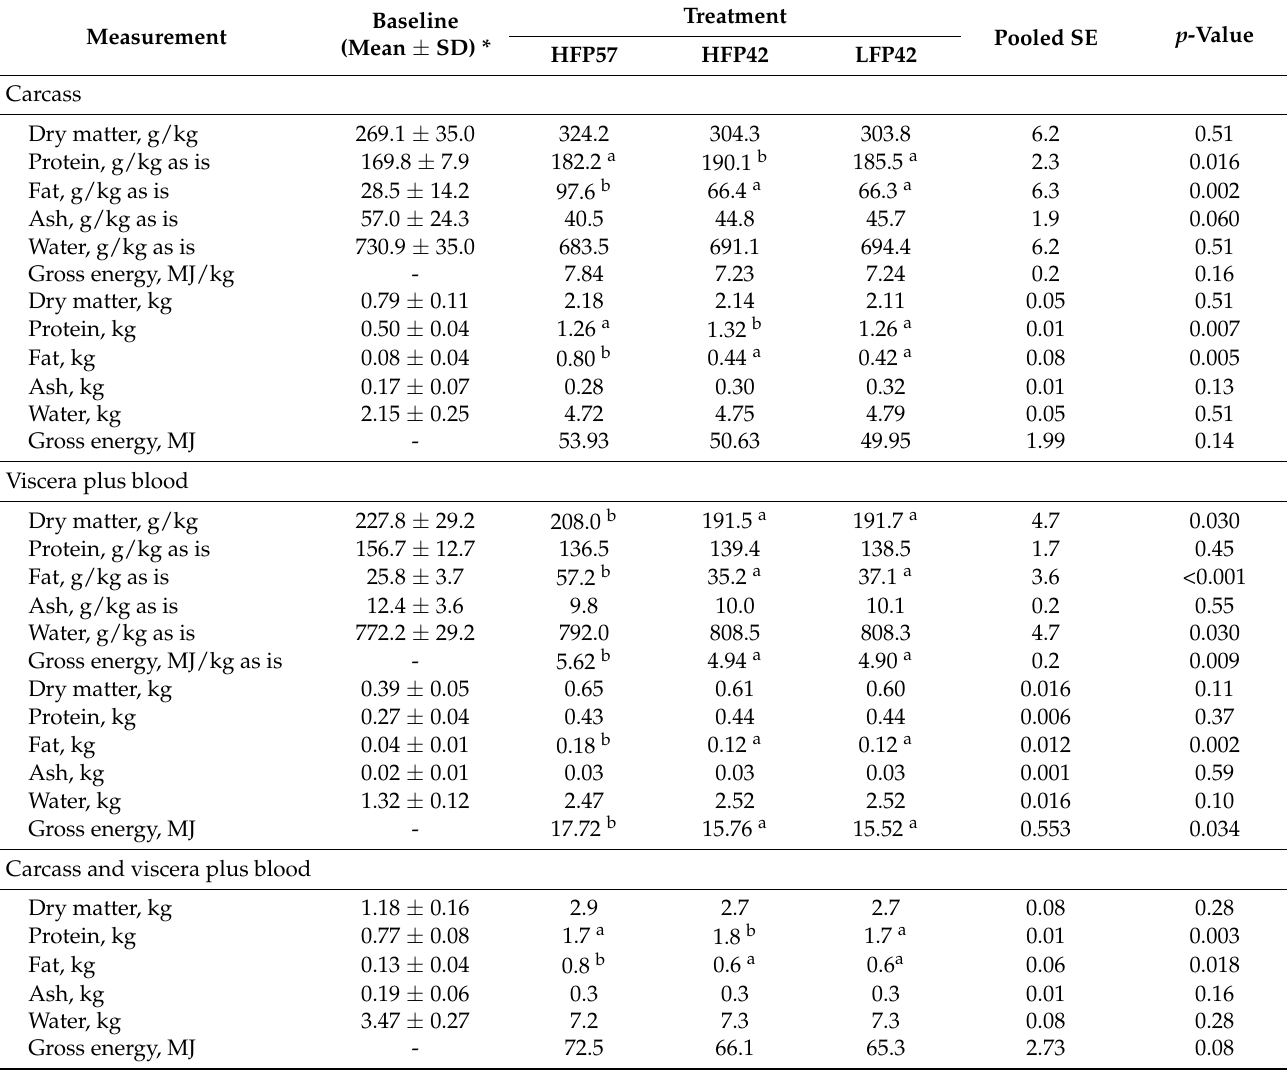
Table 7. Chemical composition of carcass, viscera plus blood and the whole body of lambs reared artificially using three different rearing regimens: HFP57, commercial milk replacer, high fibre concentrate pellets and milk feeding to 57 days of age; HFP42, commercial milk replacer, high fibre concentrate pellets and early weaning at 42 days of age; LFP42, high protein milk replacer from 2–16 days of age followed by commercial milk replacer, low fibre concentrate pellets and early weaning at 42 days of